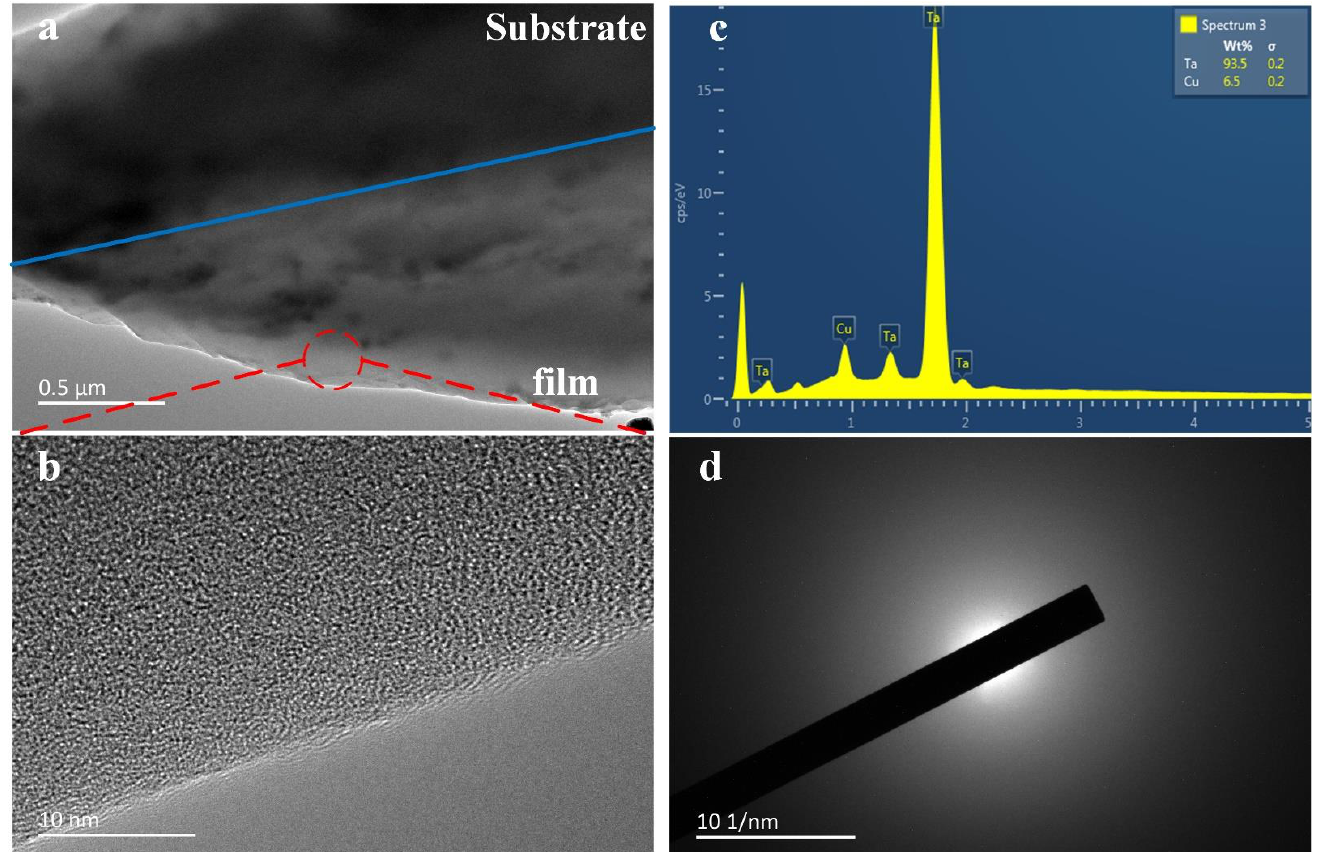
Figure 4. TEM characterization of Cu3.5Ta96.5 film. ( a ) The inner structure of Cu-Ta alloy film; ( b ) A partial enlargement of red circle in ( a ), obviously amorphous state; ( c ) The EDS spectrum of Cu3.5Ta96.5; ( d ) Selected area diffraction patterns sampling Cu3.5Ta96.5.